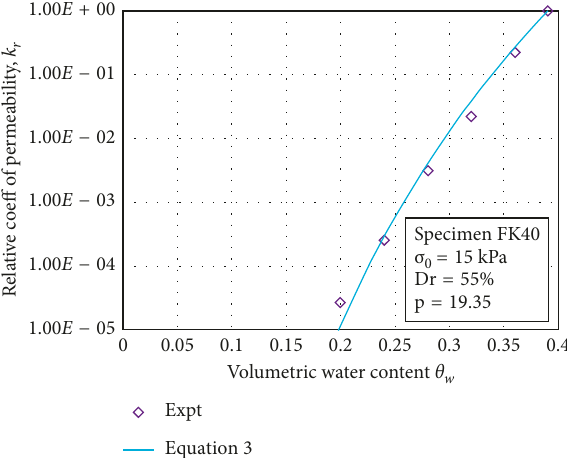
Figure 13: Permeability changes against volumetric water content for FK20 soils.